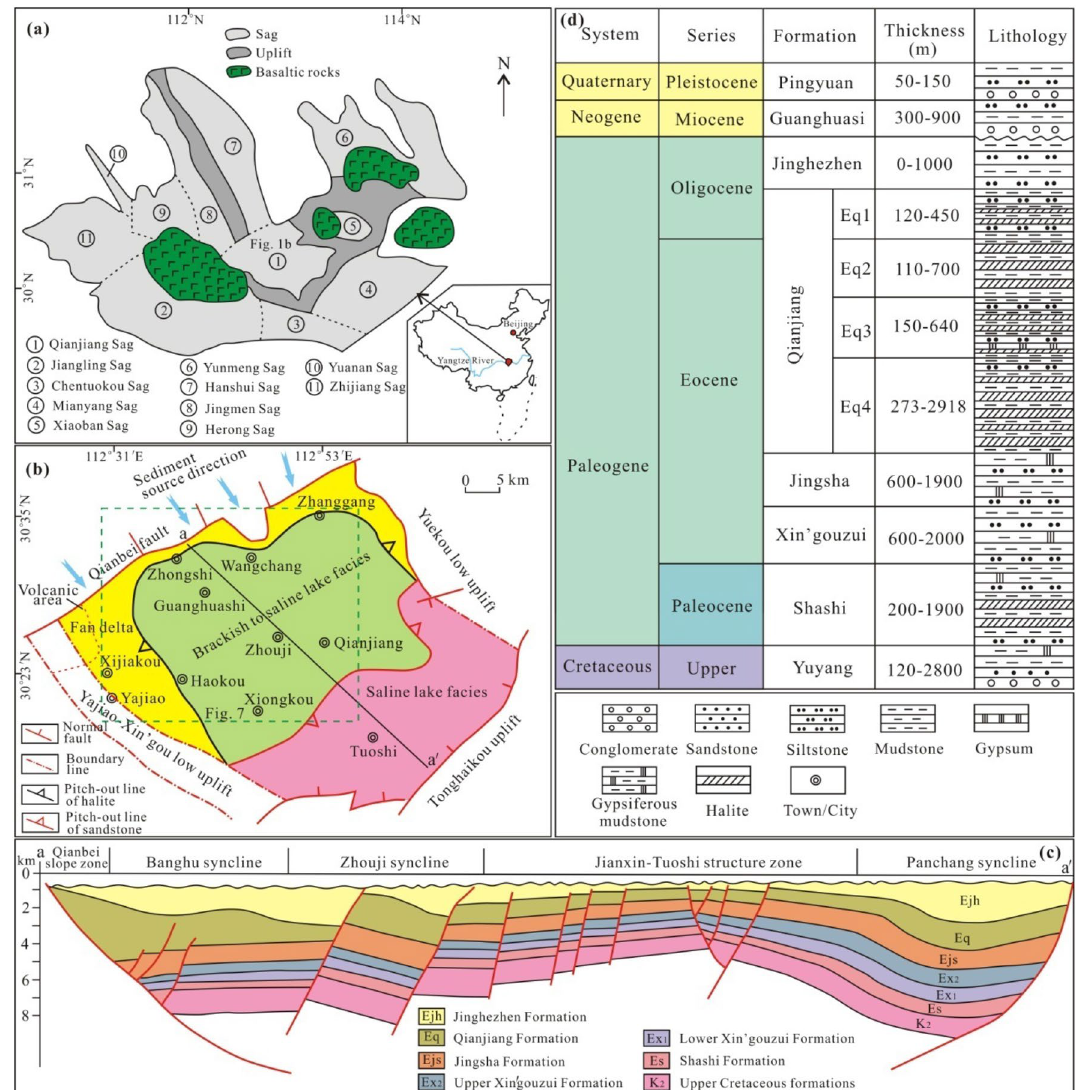
Figure 1. ( a ) Division of tectonic units of the Jianghan Basin 24 . ( b ) Sedimentary facies of the Qianjiang Formation of the Qianjiang Depression 24 . ( c ) Interpreted seismic profiles of the Qianjiang Depression. The location of the seismic profile is shown in ( b ). ( d ) Stratigraphic column of the Qianjiang Depression 24